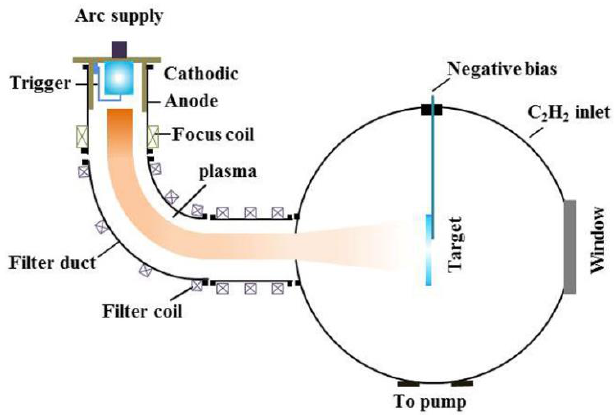
Figure 1. The schematic diagram of the FCVA (filtered cathodic vacuum arc) deposition system.